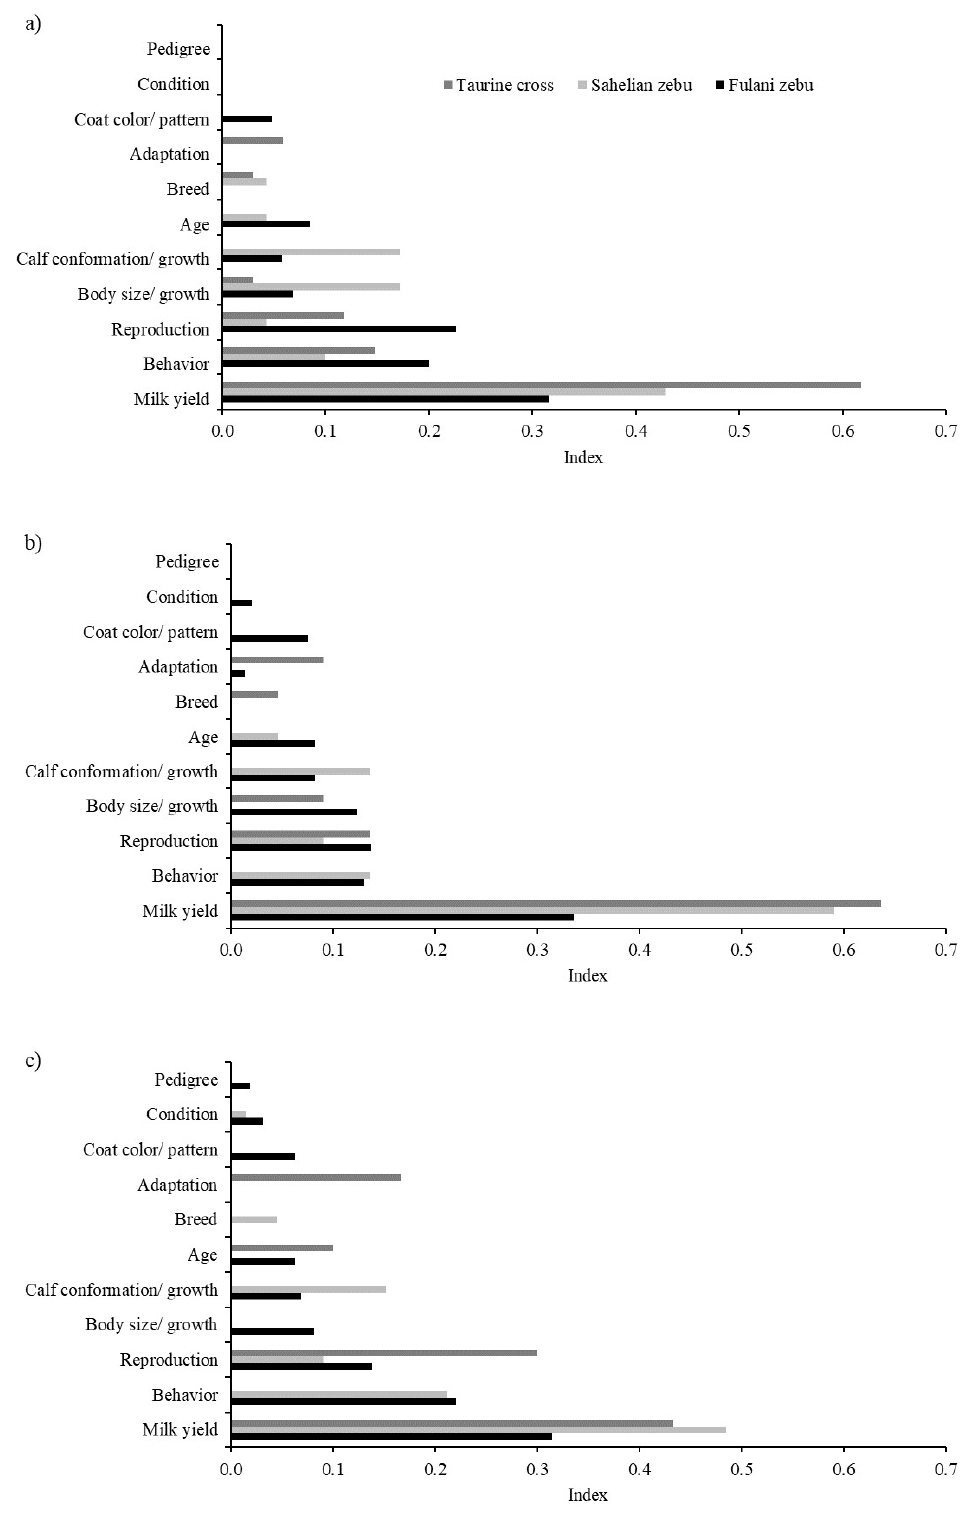
Figure 3. Relative importance (weighted index) of reasons for ranking individual cows as best ( a ), average ( b ) and poor ( c ) within breeds. Maximum of three reasons where the most important reason was weighted by 3, the second most important reason by 2 and the third most important reason by 1.